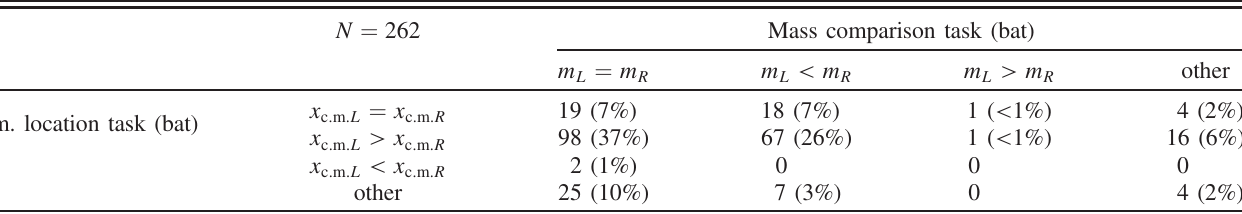
TABLE I. Results from pretests in which students were asked both the c.m. location and mass comparison tasks (with percentages of the